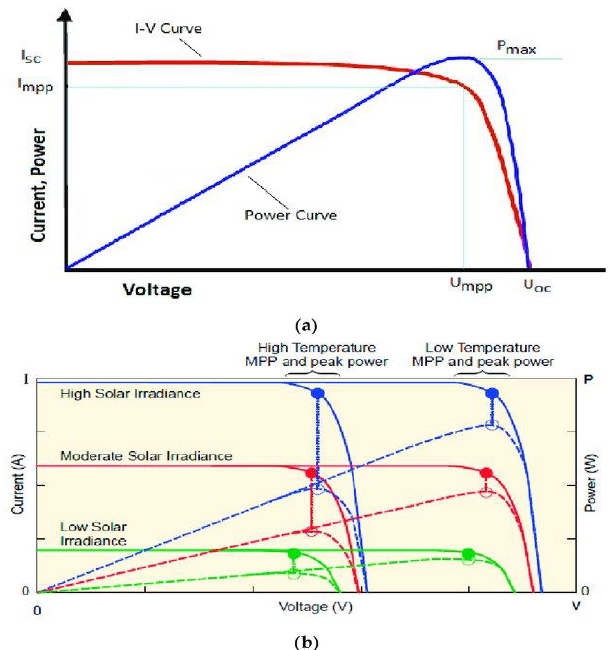
Fig. 1 . Electrical characteristics of a solar photovoltaic cell [4] Where P is Power at the MPP, I is Short circuit max sc current, I is Current at MPP, V is Open circuit mpp oc voltage, and V is Voltage at MPP. mpp